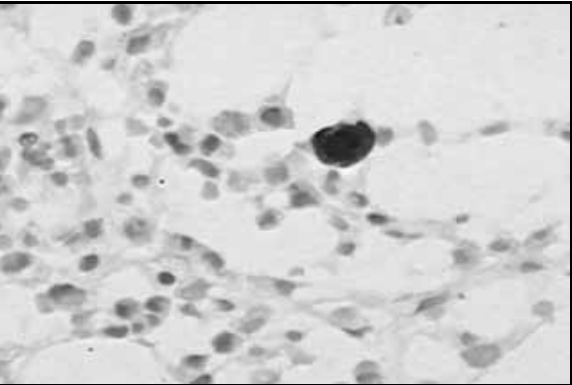
Figura 3 – Biópsia de medula óssea exibindo eritroblasto com imunopositividade com o anticorpo antiparvovírus (IHQ, 40×) IHQ: